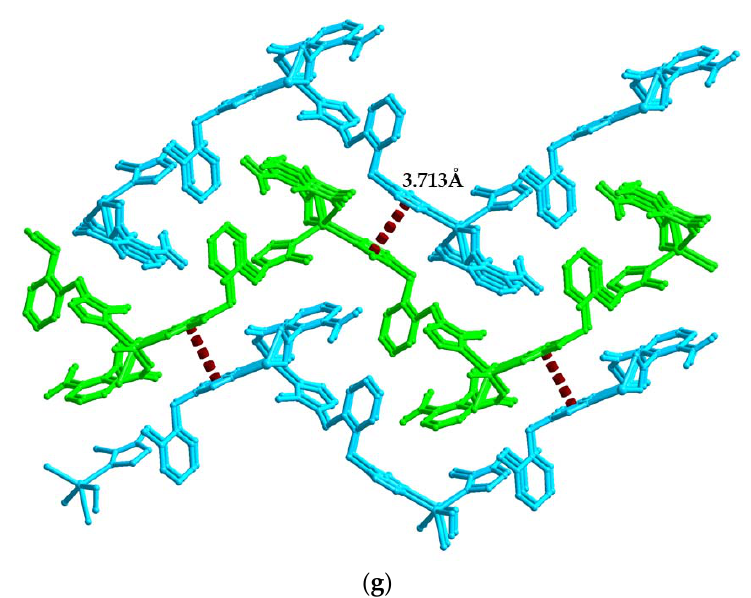
Figure 4. ( a ) The coordination environment of the Cd II ion in complex 4 ; ( b ) The coordination mode of the 3 ‐ npa ligand; ( c ) The 1D [Cd(1,2 ‐ bmimb)]n “Z” chain; ( d ) The 1D [Cd(3 ‐ npa)]n chain structure; ( e ) The 2D layered structure; ( f ) The sql topology of the complex 4 ; ( g ) The 3D supramolecular structure by π∙∙∙π interactions (green, Cd; blue, N; red, O; gray, C; pink, H).